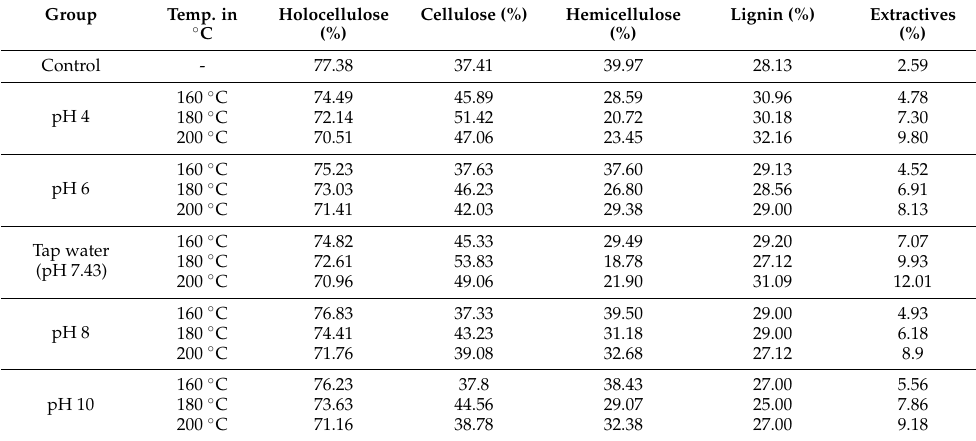
Lignin (%) Extractives (%) (%)